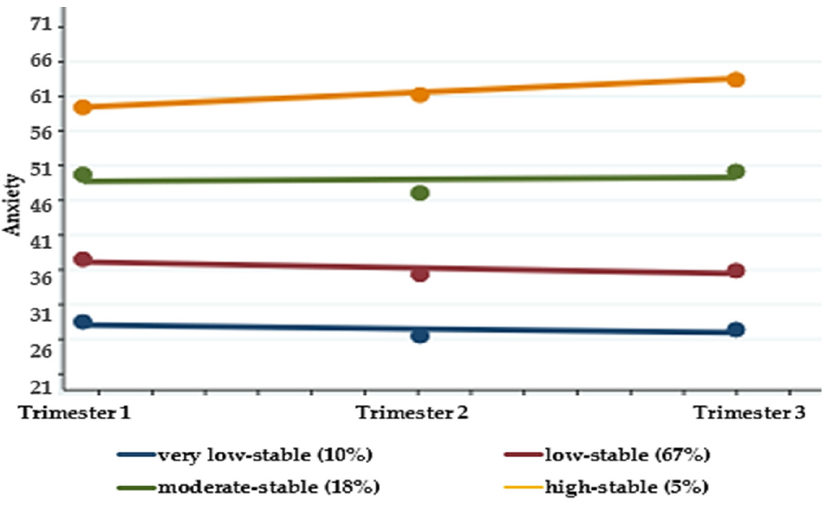
Figure 2. Trajectory groups for anxiety of pregnant women ( n = 136).